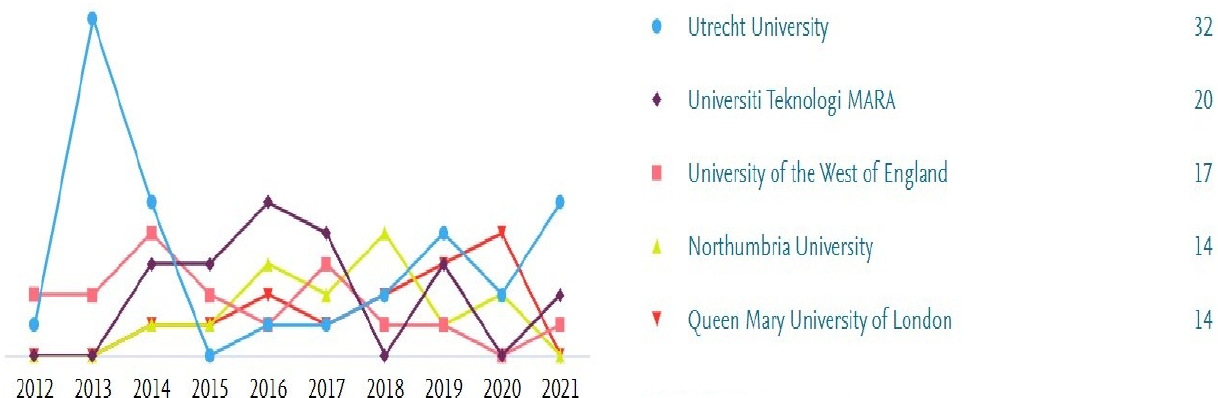
Figure 6. Top five institutions by scholarly output, 2012 to 2021.